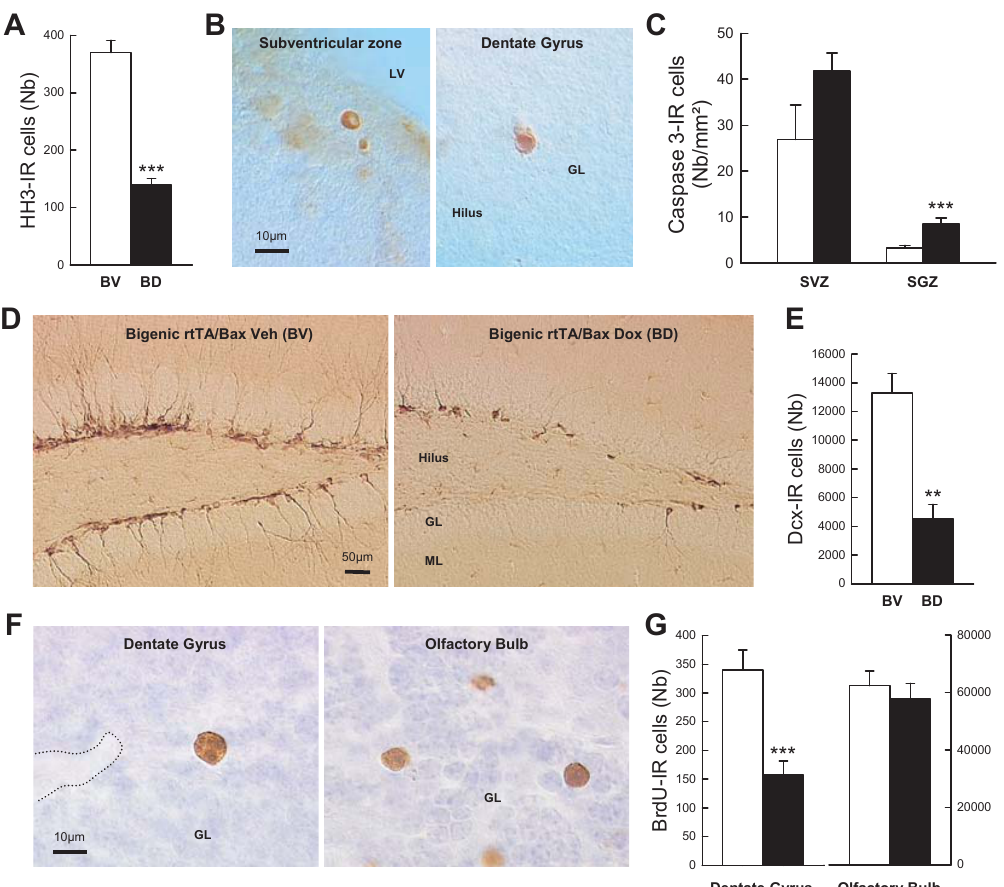
Figure 3. Effects of long-term Dox treatment on adult neurogenesis. ( A ) Number of HH3-IR cells in the dentate gyrus (DG) of bigenic mice treated with (BD, black) or without (BV, white) Dox. ( B ) Illustration of Caspase 3-IR cells in the subventricular zone (SVZ) and the subgranular zone (SGZ) of the DG. ( C ) Density of Caspase 3-IR cells in the SVZ and the SGZ of bigenic (black) and control mice (white) treated with Dox. ( D ) Illustrations of immature neurons visualized by Dcx staining in the DG. ( E) Number of Dcx-IR immature neurons in the DG of bigenic mice treated with (black) or without (white) Dox. ( F) Number of one-month-old BrdU-IR cells in the DG and the OB of bigenic (black) and control mice (white) treated with Dox. **: p # 0.01 and ***: p # 0.001 compared to control